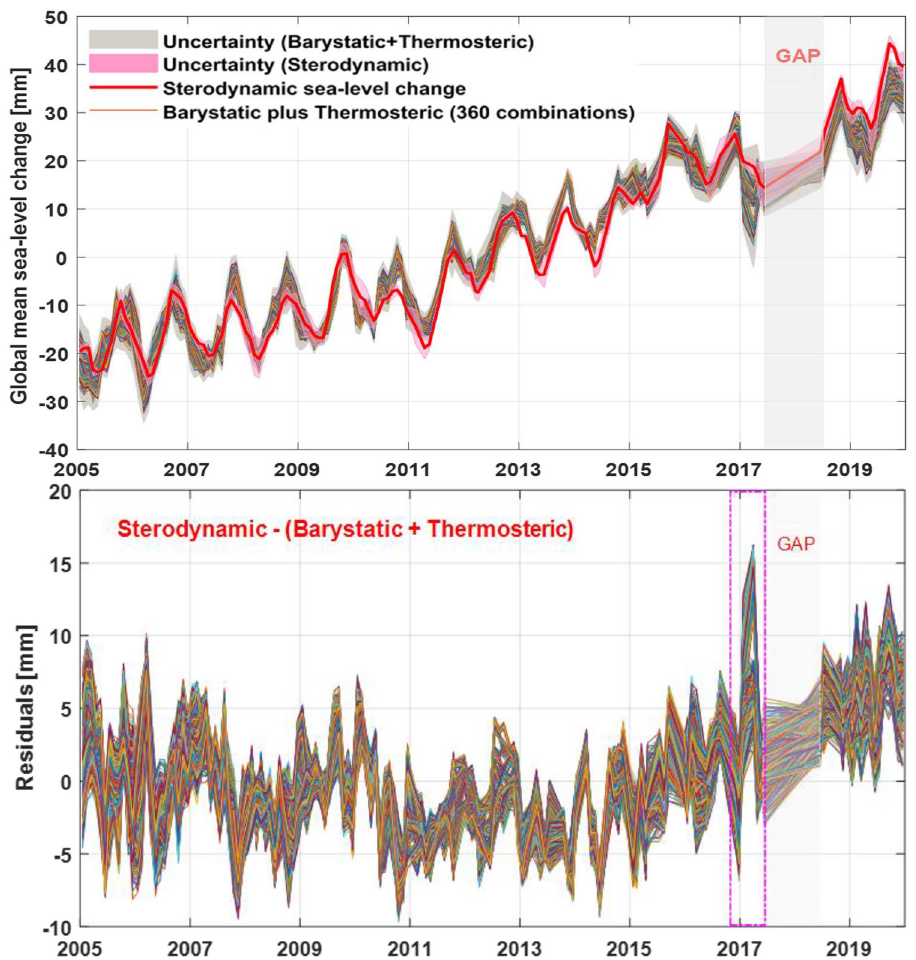
Figure 5. The global mean sterodynamic and sea-level change estimation from Altimetry and Argo plus GRACE and GRACE-FO observations and corresponding differences from 2005 to